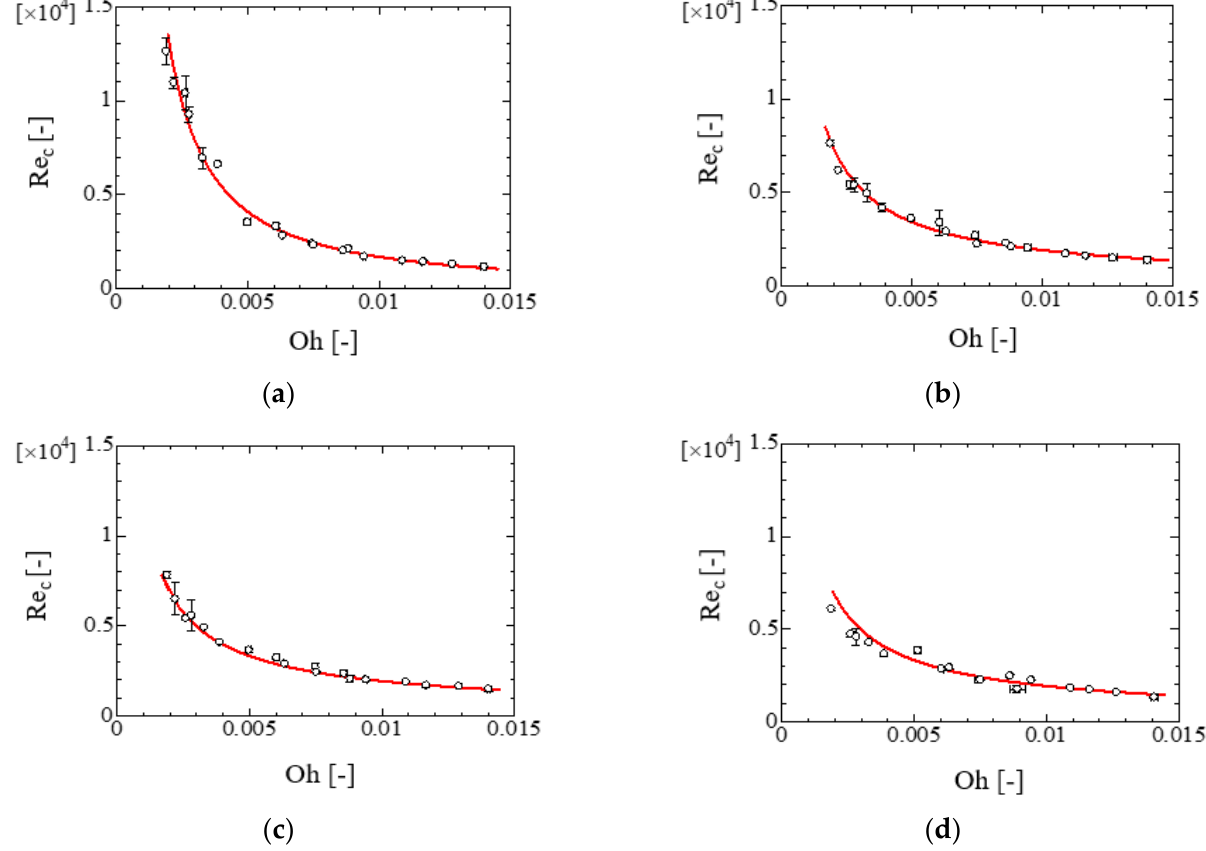
Figure 12. The relationship between Re c and Oh: ( a ) bare substrate; ( b ) #400 substrate; ( c ) #240 substrate; and ( d ) #120 substrate. The error indicates two standard deviation (2SD).